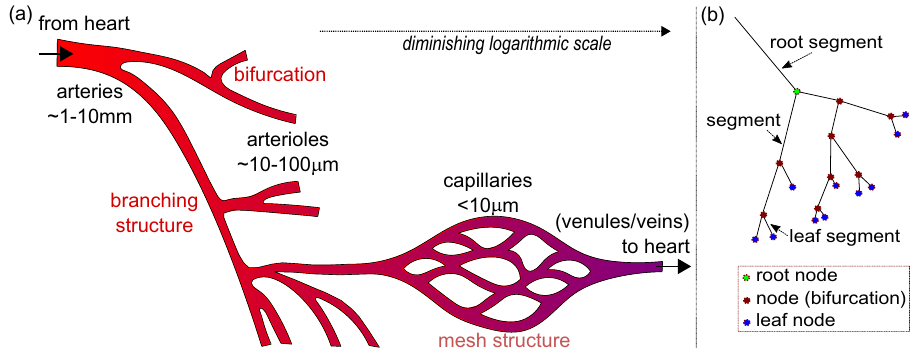
Figure 1. ( a ) Schematic showing the relative sizes and structures of arteries, arterioles and capillaries. The scale of the features diminishes logarithmically from left to right. Arteries supply organs and typically have sizes greater than approximately 1 mm (with the aorta the largest artery with a 2–3 cm diameter). Arterioles are typically less than 100 µ m in diameter and distribute blood within organs via a branching structure. We note that the boundary between scales of arteries and arterioles is blurred. Capillaries have a mesh like structure and control the distribution of nutrients, particularly oxygen, to tissue. After leaving the capillaries, blood